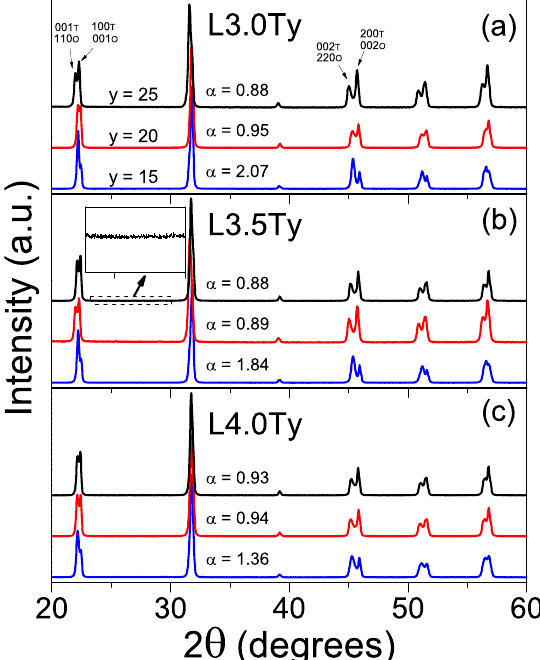
Figure 6. XRD patterns for the LKNNT ceramics, sintered at 1110 ◦ C for 2 h, with compositions ( a ) L3.0Ty, ( b ) L3.5Ty and ( c ) L4.0Ty. The 001, 100, 002 and 200 peaks of the tetragonal phase were identified with the (T) letter, while the 110, 001, 220 and 002 peaks of the orthorhombic phase were identified in with the (O) letter.